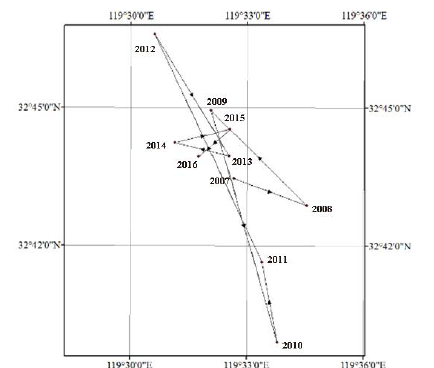
Figure 5. Migration of Jiangsu AOD gravity center